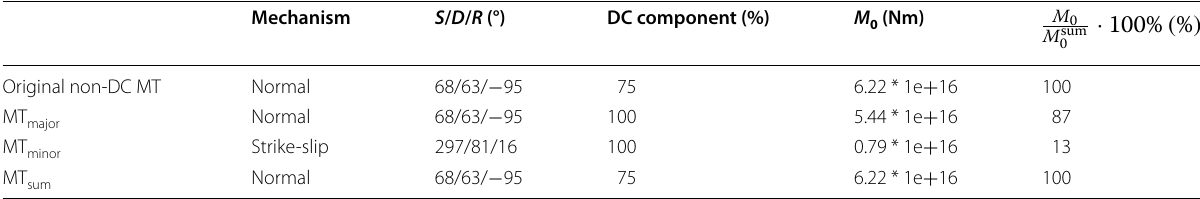
5.4 aftershock from 2016/4/16 16:02:01 JST (event No. JMA